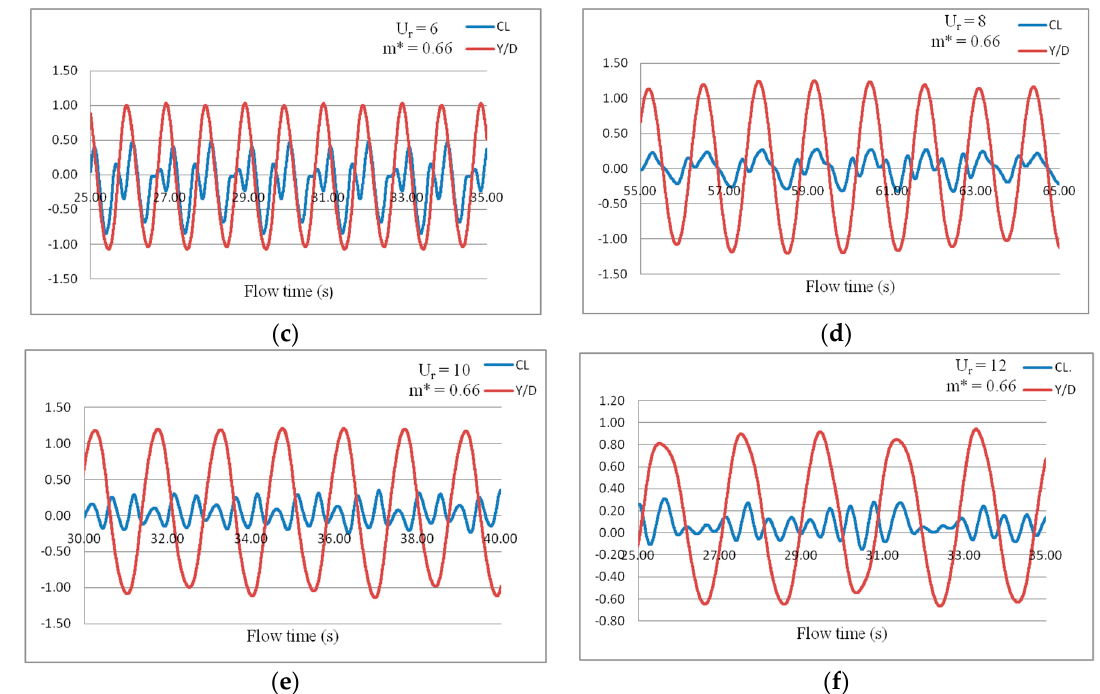
Figure 7. Variation of C L with Y/D for m* = 0.66 ( a ) U r = 4; ( b ) U r = 5; ( c ) U r = 6; ( d ) U r = 8; ( e ) U r = 10; ( f ) U r = 12.